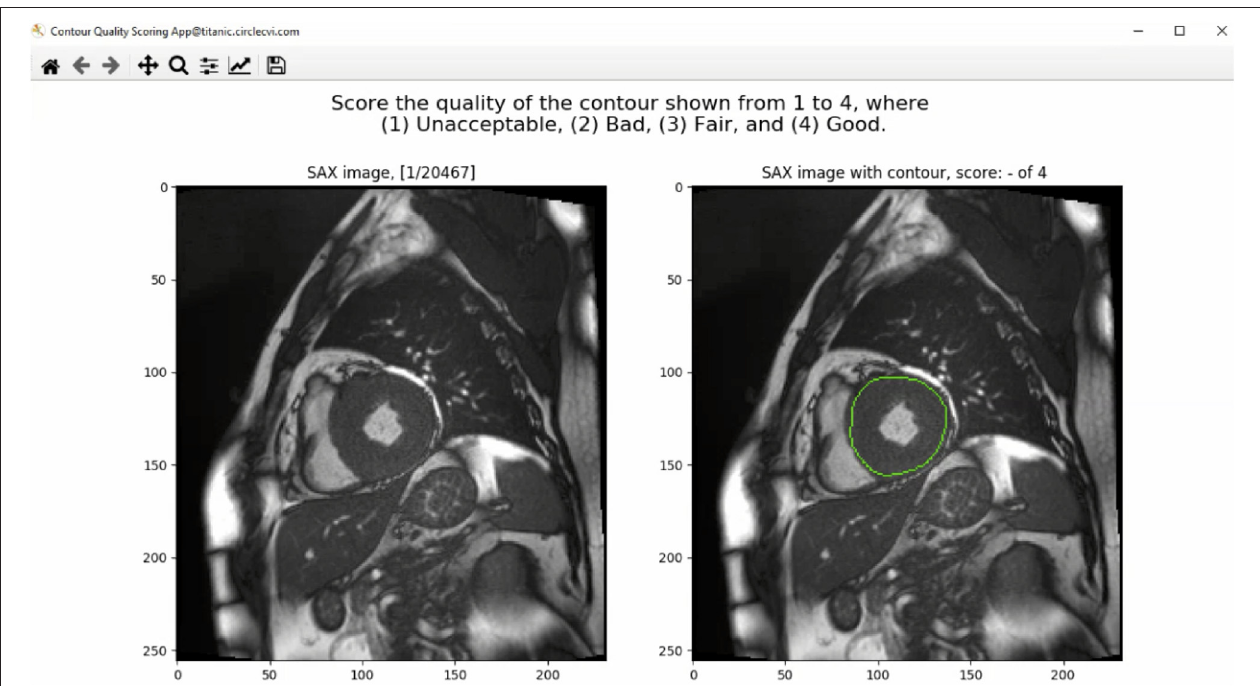
FIGURE 1 | The graphical user interface (GUI) of the contour quality scoring tool. The left panel shows the current SAX image. The right panel shows the same image with overlaid contour to which the rater is asked to assign a quality score. The title above the right panel shows a blank quality score, which will be updated when a value is entered by the